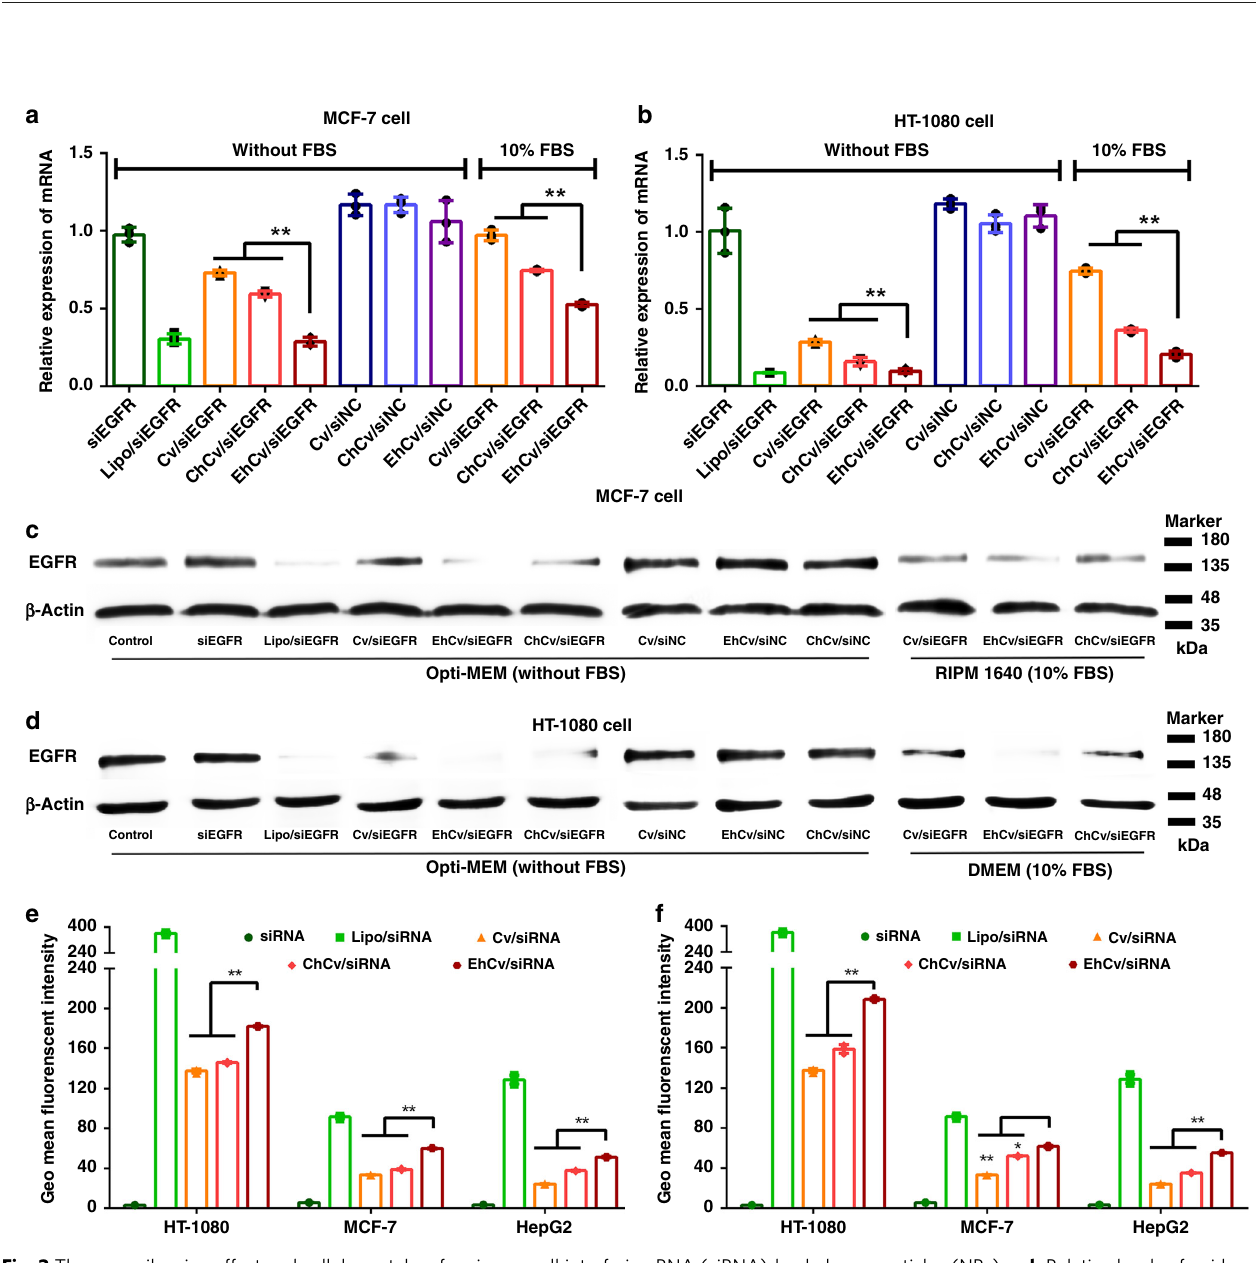
Fig. 3 The gene silencing effect and cellular uptake of various small interfering RNA (siRNA)-loaded nanoparticles (NPs). a , b Relative levels of epidermal growth factor receptor (EGFR) mRNA on MCF-7 cells and HT-1080 cells detected by reverse transcriptase-PCR, respectively. c , d Expression levels of EGFR protein on MCF-7 cells and HT-1080 cells detected by western blot assay, respectively. e , f Intracellular fl uorescence intensities on MCF-7, HT-1080, and HepG2 cells detected by fl ow cytometry (FAM-labeled siNC: 100 nM). The fi nal concentration of siRNA was 100 nM. Data are shown as mean ± SD (n = 3). * p < 0.05, ** p < 0.01, analysis of variance MCF-7 cells (Fig. 3a, e) in a positive-charge-independent manner. decorated rEhCv/siEGFR NPs (Fig. 4a) showed similar hydro- To further certify the key function of EM proteins, the proteins dynamic diameter and zeta potential (197.0 ± 11.7 nm, 30.4 ± 4.1 were removed from EM by 100 mM sodium carbonate 37 and the mV) with the EhCv/siRNA NPs (Supplementary Fig. 7a and incomplete EM was named as rEM. The incomplete EM- Supplementary Table 1). However, different from the complete NATURE COMMUNICATIONS| (2019) 10:2702